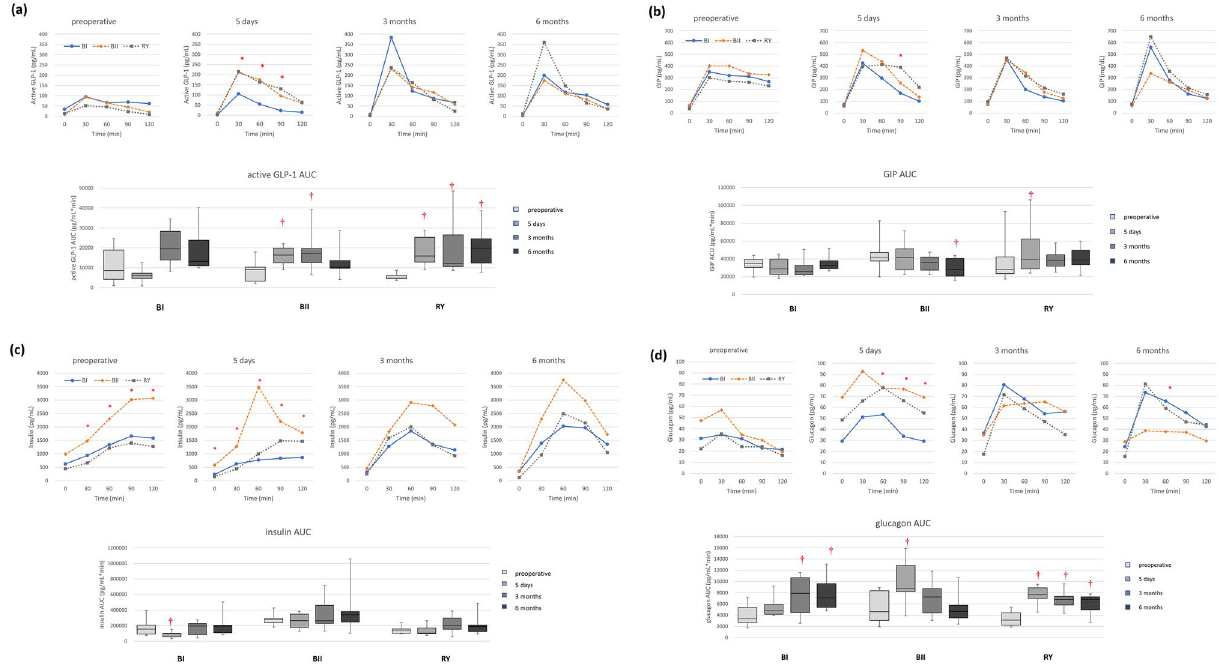
Figure 6. Dynamic changes and area under curve (AUC) during oral glucose tolerance test in ( a ) active glucagon-like peptide-1 (GLP-1), ( b ) glucose-dependent insulinotropic peptide (GIP), ( c ) insulin, and ( d ) glucagon (*p < 0.005 between the groups, † p < 0.005 compared to the baseline value; BI billroth I, BII Billroth II, RY